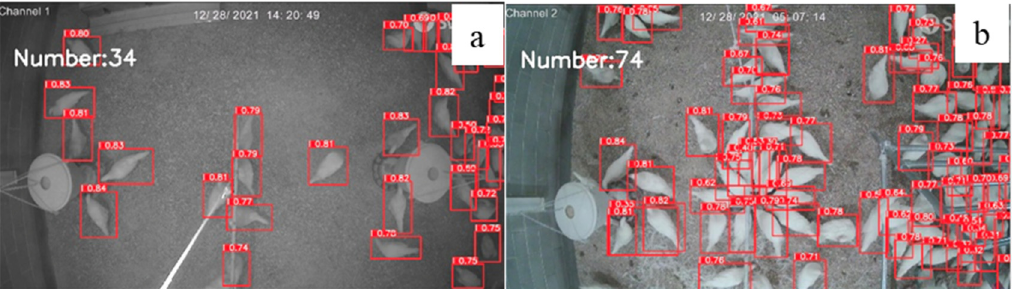
Figure 7. Number of chickens identified under low density and moderate density by our model: low density ( a ) vs. moderate density ( b ).